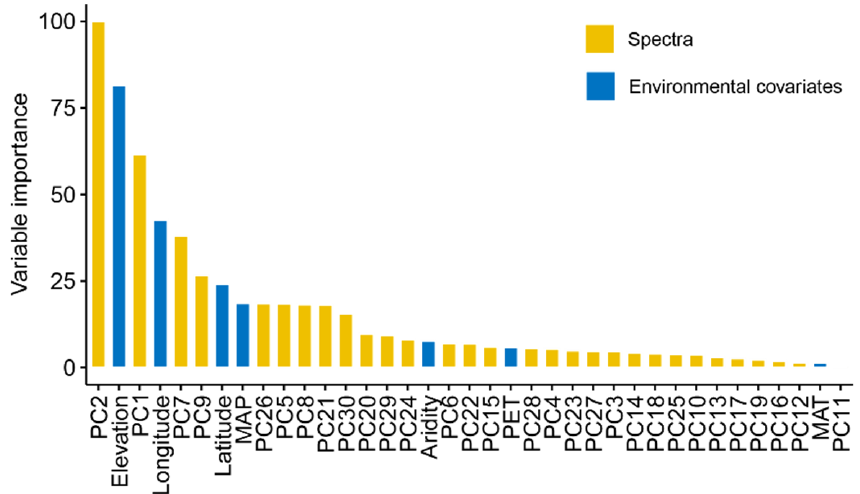
Figure 6. Variable importance of XGBoost model in EC prediction.